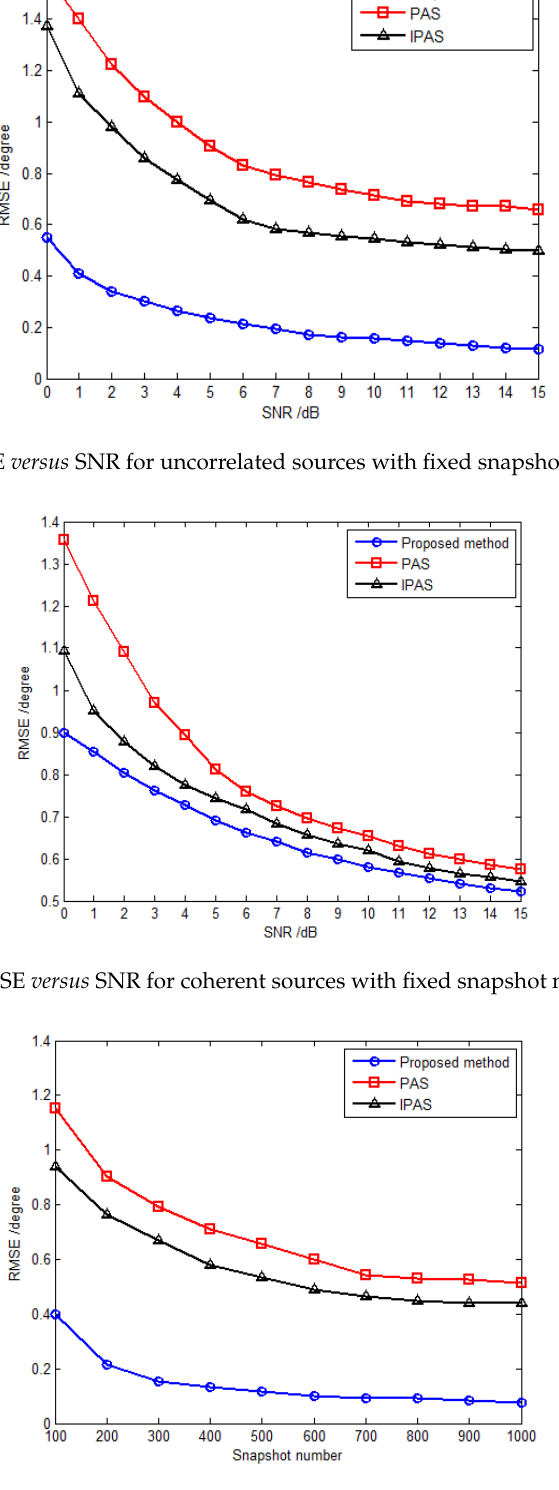
Figure 8. RMSE versus snapshot number for uncorrelated sources with fixed SNR 15 dB.